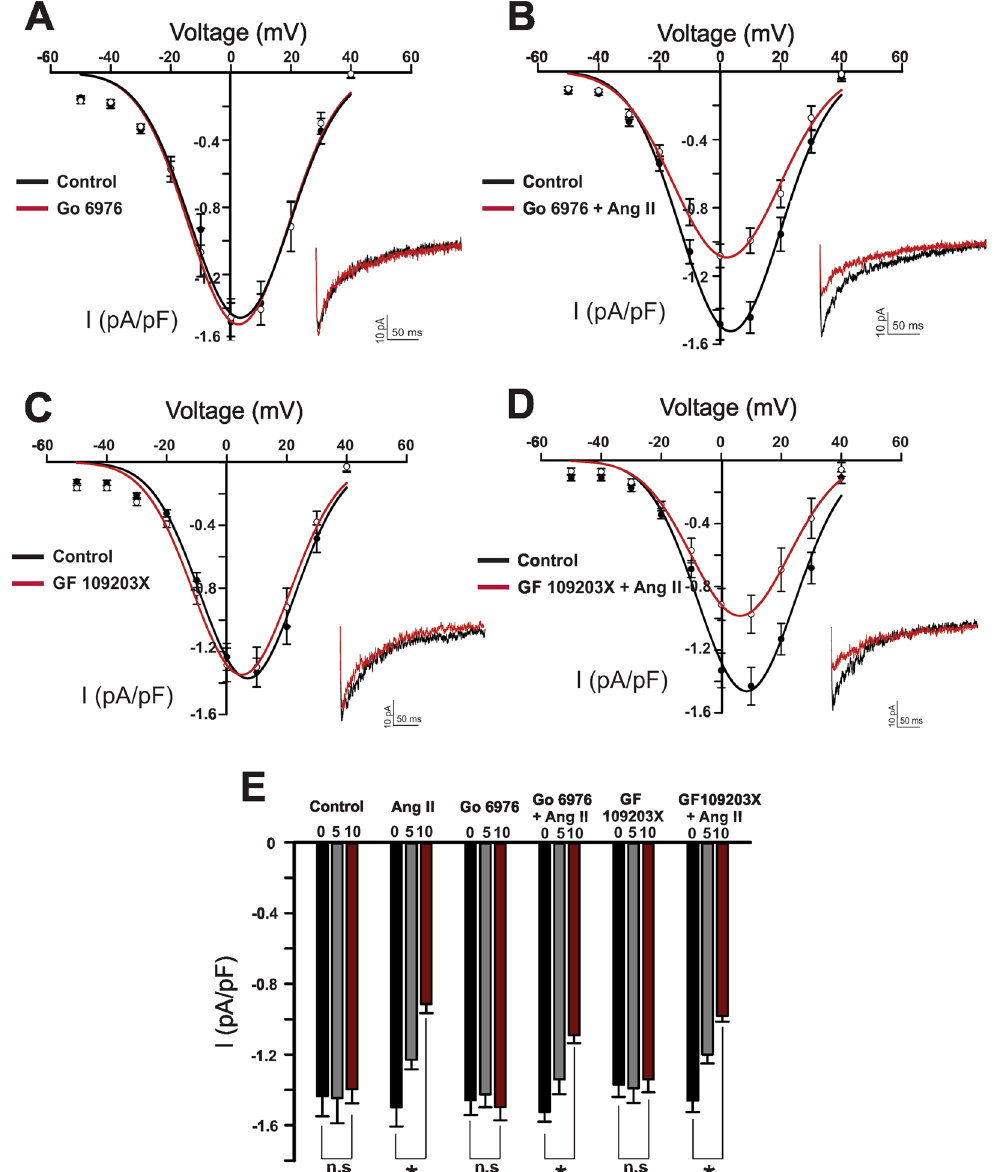
Figure 2. Protein Kinase C (PKC) is not involved in angiotensin II-mediated inhibition of T-type Ca 2 + channels. ( A ) Representative trace, and averaged I-V plots of whole cell T-type current, prior to and after the application of Go 6976 (conventional PKC inhibitor, 100 nM) (n = 8). ( B ) Representative trace and average I-V plot highlighting the inability of Go 6976 to abolish Ang II (100 nM) mediated inhibition of the T-type current (n = 8). ( C ) Representative trace, averaged I-V plots of the whole cell T-type current, prior to and following the application of GF 109203X (non-selective PKC inhibitor, 100 nM) (n = 9). ( D ) Representative trace and average I-V plot highlighting the inability of GF 109203X to abolish Ang II (100 nM) mediated inhibition of the T-type current (n = 8). ( E ) Peak T-type current (pA/pF) at 5 min intervals under control condition (n = 8) and in cells treated with either Go 6976 or GF 109203X ± Ang II (100 nM) (n = 8–9). * Denotes significant difference compared to control ( * P < 0.05, paired t